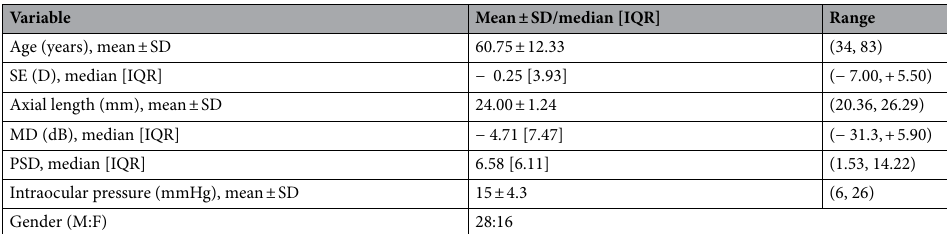
Table 1. Characteristics of the patients with glaucoma that we recruited from the King Khaled Eye Specialist Hospital and from the Indiana University School of Optometry. SD standard deviation, D diopter, IQR interquartile range, MD mean deviation, PSD pattern standard deviation, dB decibels, SE spherical equivalent.